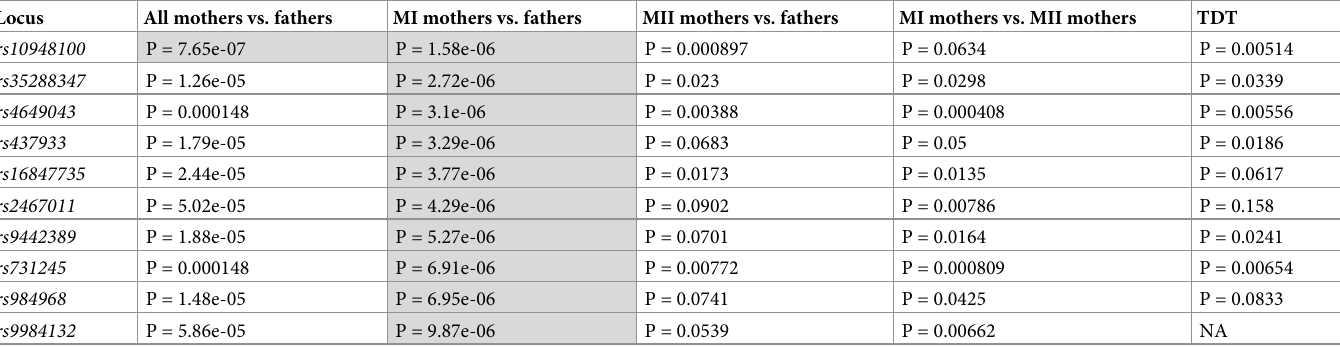
Table 4. Top hits from the MI mothers vs. fathers genome-wide association study. Locus All mothers vs. fathers MI mothers vs. fathers MII mothers vs. fathers MI mothers vs. MII